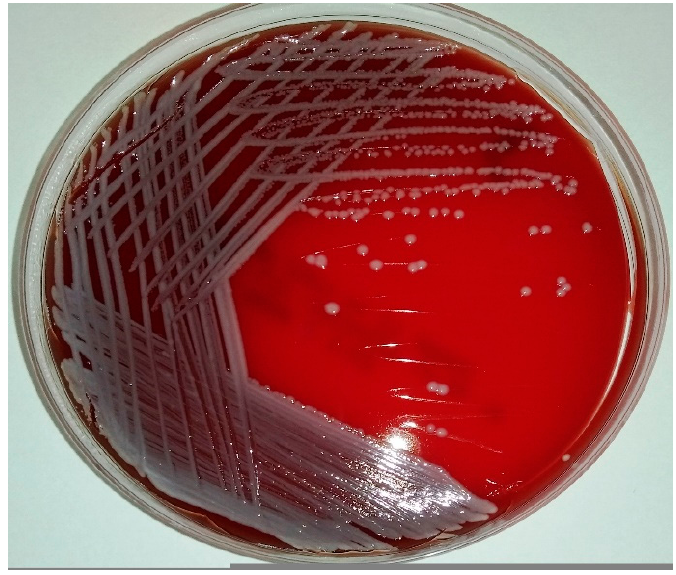
Figure 1. Colonies of S. agnetis (GenBank: MT231940) on Columbia agar with 5% sheep blood.